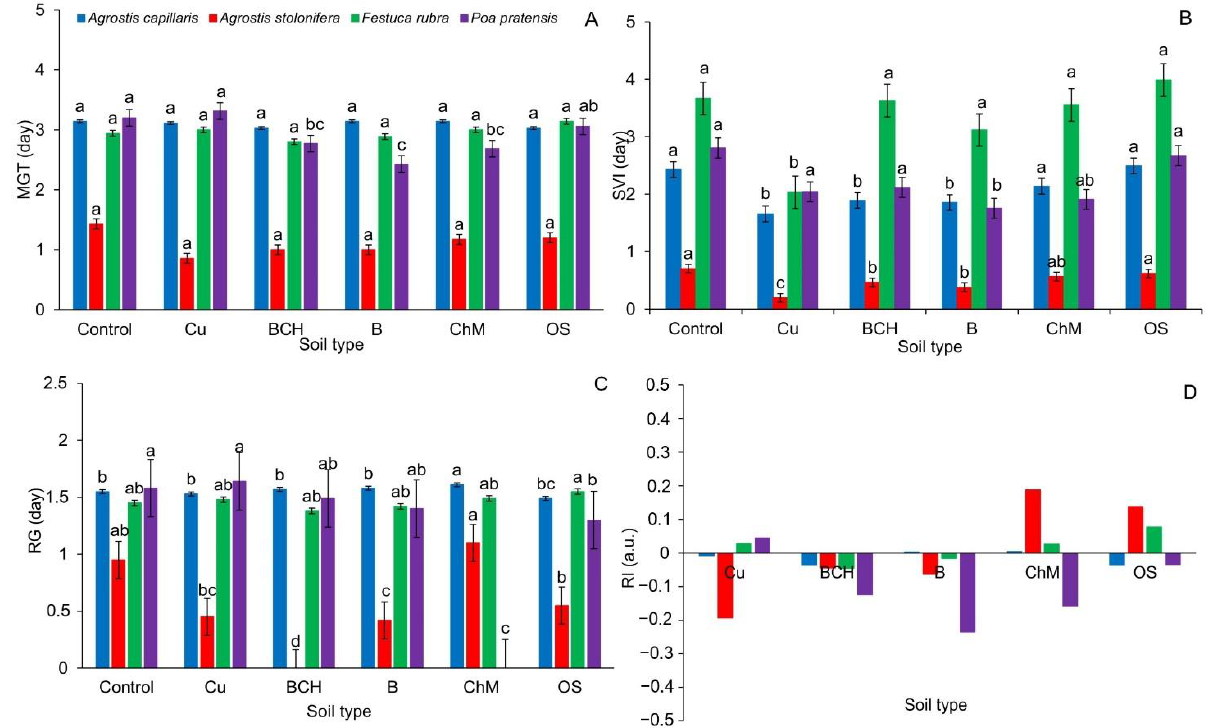
Figure 1. Selected germination indexes of grass seeds ( A – MGT — mean germination time, B – SVI — seed vigor index, C – RG — rate of germination, D – RI — contamination soil effect response index) on various modifications of soil contaminated with copper; Cu — copper soil, copper soil with sorbents: BCH — biochar, B — bentonite, ChM — chicken manure, OS — organo-zeolitic substrate; mean values ( n = 5; ± SD) marked with different letters (within each species) differ significantly according to Duncan's test with p ≤ 0.05.